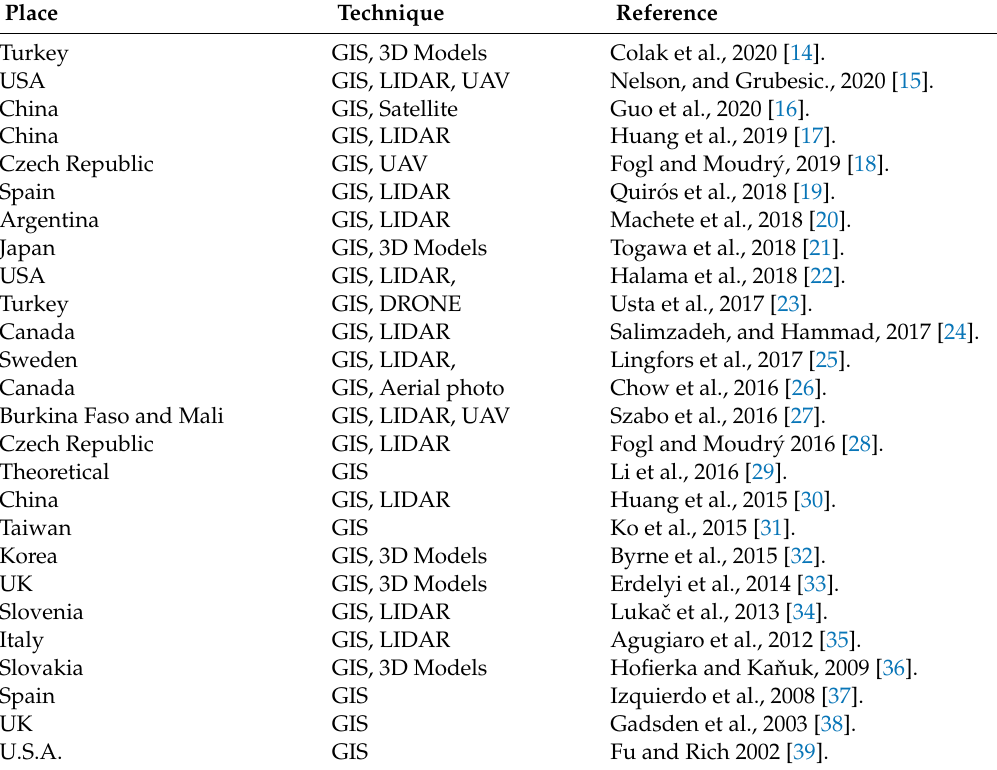
Table 2. Studies around the world that have implemented solar radiation analysis with geographic information